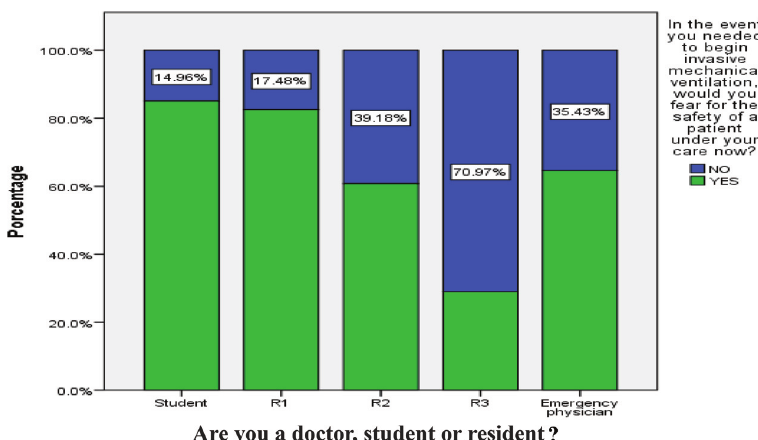
Figure 1 - Students, residents and physicians in the study sample. Table 2 - Percentage of physicians who considered themselves able to set the PCV mode. Category